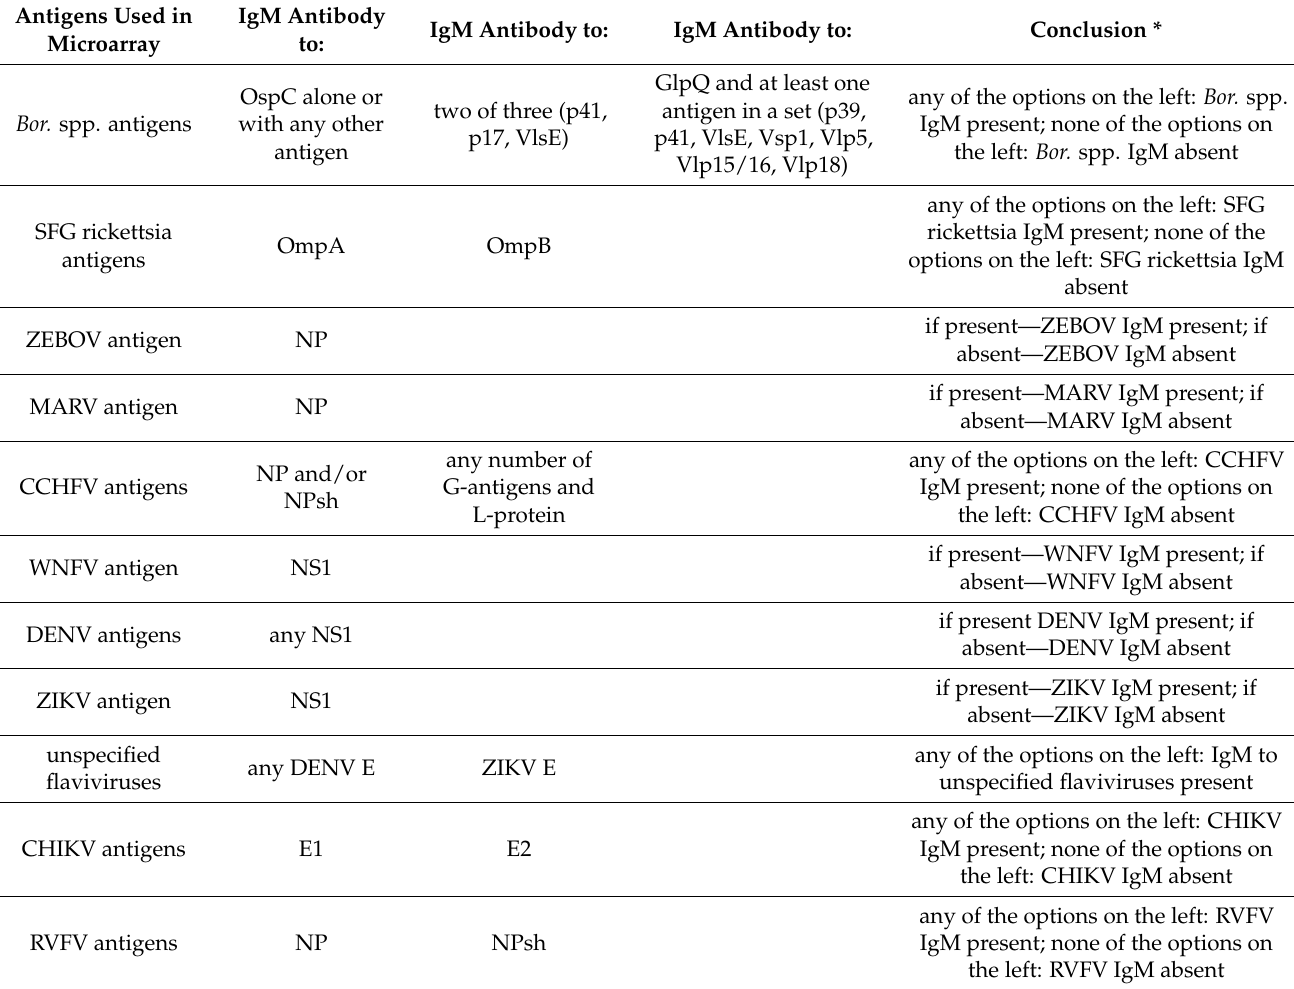
Table 2. Algorithms for the interpretation of microarray